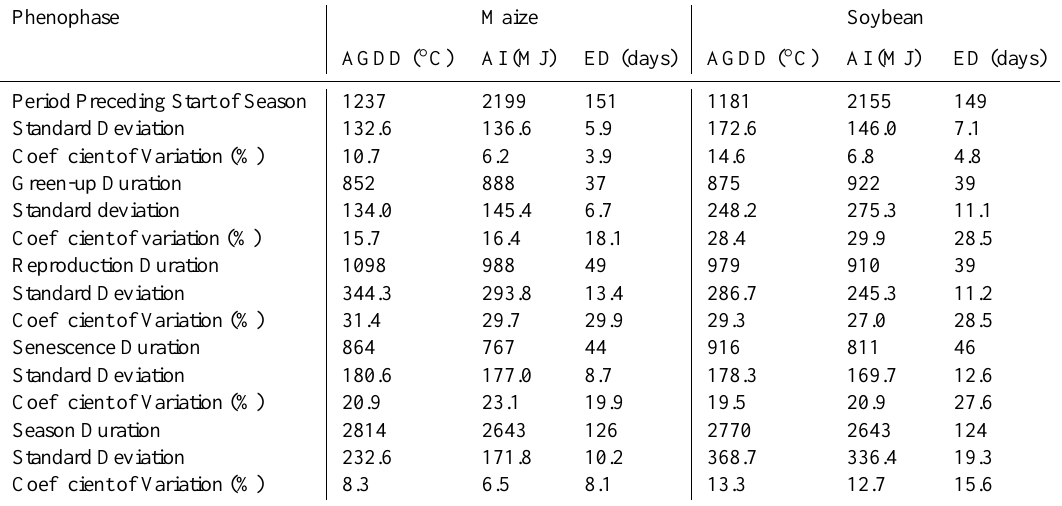
Table 3. Durations of phenological phases and seasons for different crops measured in control variables (AGDD = accumulated growing degree-days, AI = accumulated insolation, ED = elapsed days). Phenophase